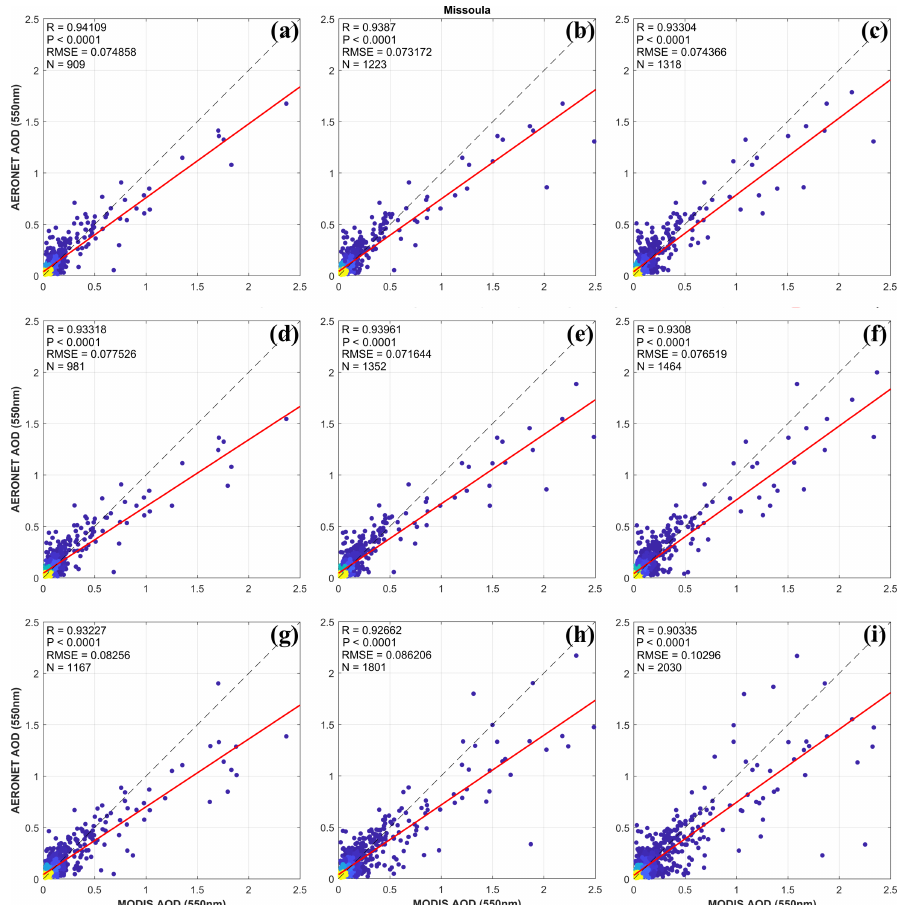
Figure 4. Scatter plots representing the validation of Aqua MODIS DB AOD against AERONET AOD processed at 550 nm of the representative Missoula station: Nearest single pixel in time ( a ) nearest singel pixel in space, averaged from nearest ( b ) 9 pixels, and ( c ) 25 pixels; 30 min averaging domain ( d ) nearest single pixel in time, averaged from nearest ( e ) 9 pixels, and ( f ) 25 pixels; and 3-h averaging domain ( g ) nearest single pixel in time, averaged from nearest ( h ) 9 pixels, and ( i ) 25 pixels. The red line is a regression line. Where R—Pearson correlation coefficient, P— p value, RMSE—root mean square error at 5% significance level, and N—number of matched AOD points. The one-to-one agreement is represented by the dashed